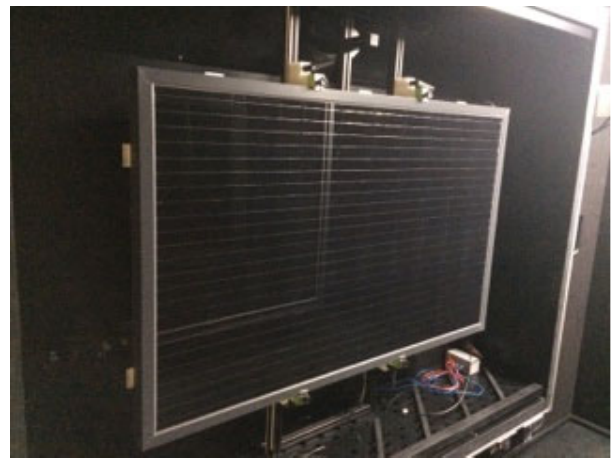
Figure 2. BIPVT module installed in the LAPSS.